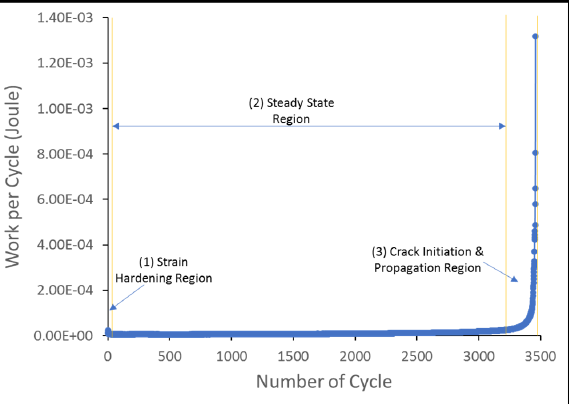
Figure 19. Inelastic work vs. the number of cycles for SAC305 solder joints cycled at 16 MPa stress amplitude until failure.